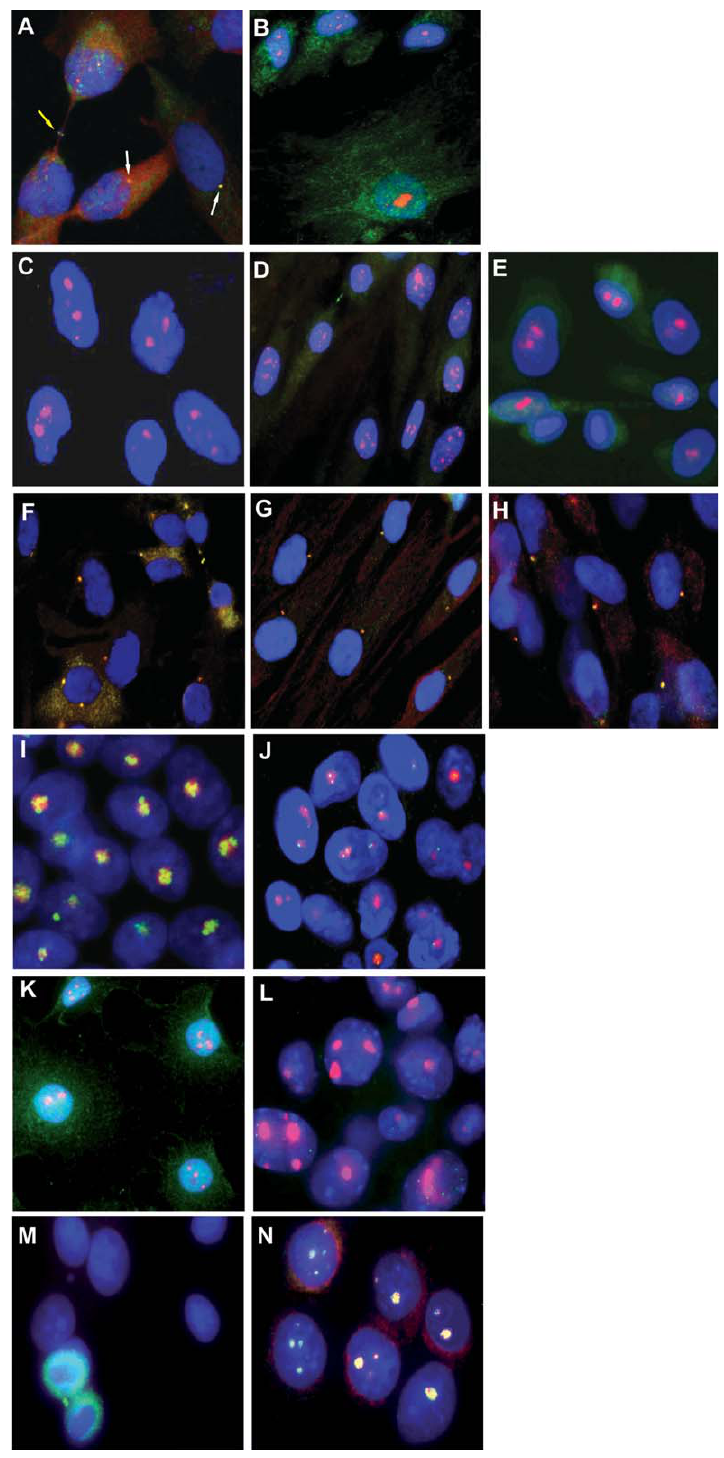
Fig. 6. Representative immunofluorescence images of MARK4L and